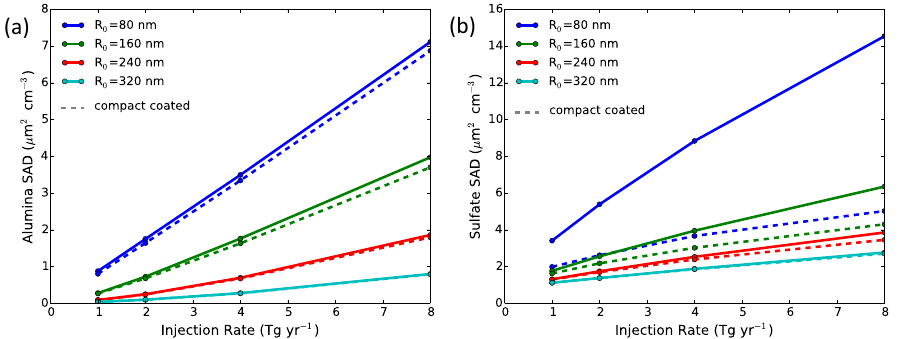
Figure 10. Global annual average stratospheric surface area density between 15 and 25km altitude for (a) uncoated alumina, and (b) total sulfate. The dashed lines represent simulations in which the coated alumina particles are assumed to become more compact in